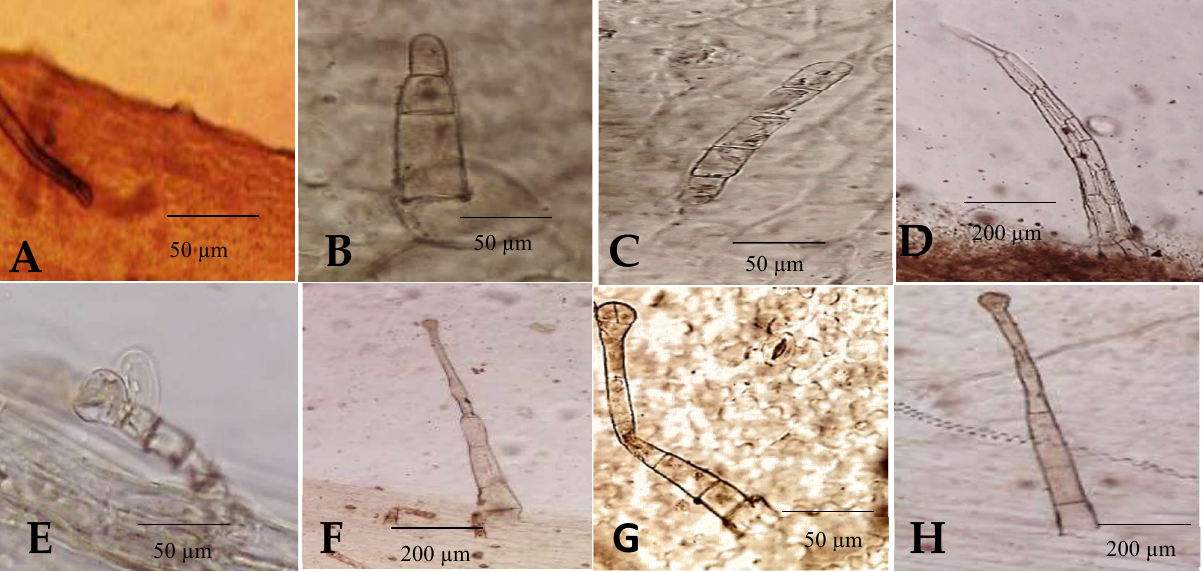
Figure 6. Light micrographs of trichomes in Cichorium : subfigures ( A – D ): non-glandular, subfigures ( E – H ): glandular.